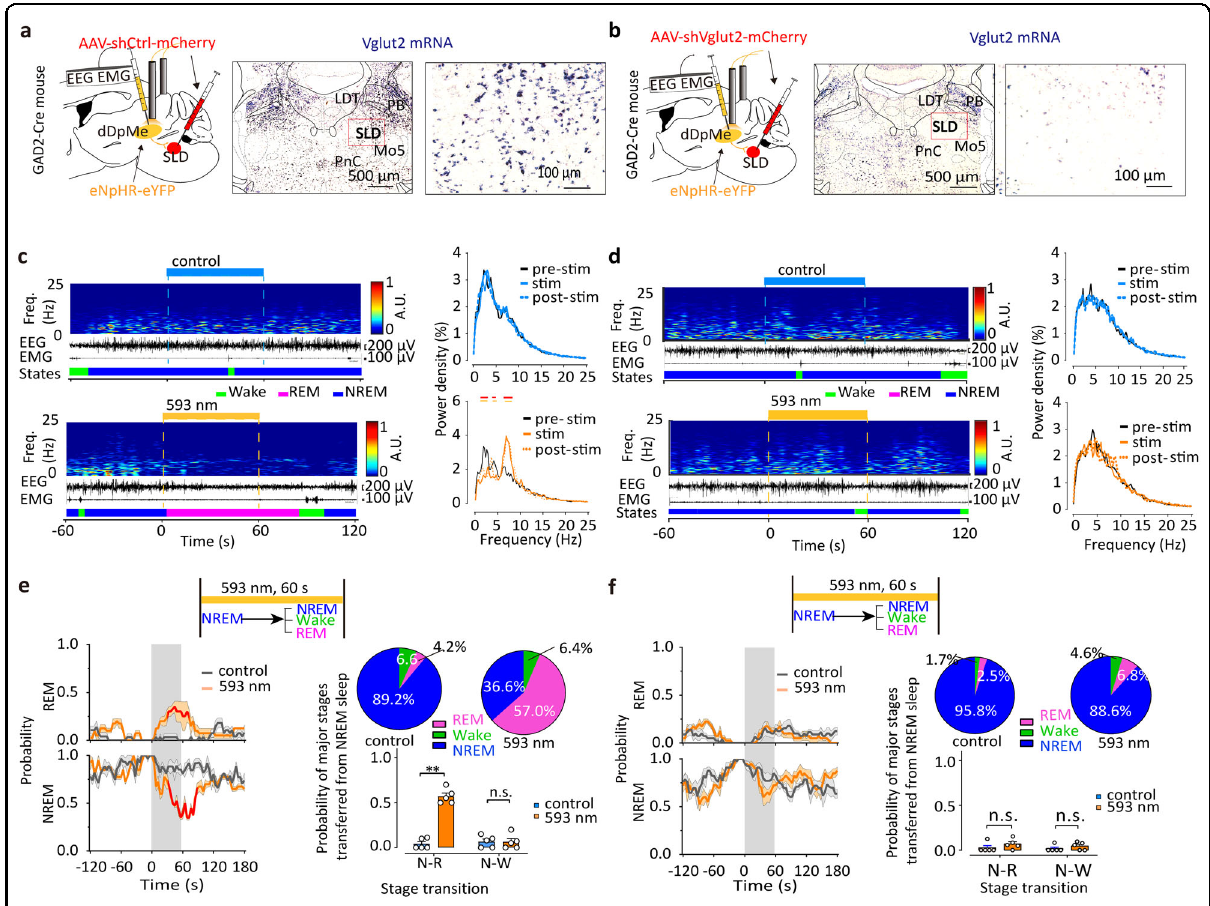
Fig. 4 dDpMe GABA → SLD Glu neural pathway is necessary for REM sleep termination and REM-to-NREM transitions. a , b Sagittal diagram for optical inhibition of the dDpMe by eNpHR after shRNA interference by shCtrl or shVglut2. shRNA interference of Vglut2 in the SLD was identi fi ed by in situ hybridization labelling Vglut2 -mRNA. c, d Typical examples of EEG power spectrograms, EEG/EMG traces, and the mean percentage of power densities from GAD2-Cre mice with bilateral 593-nm laser delivery (bottom) or 470-nm laser delivery (top) to dDpMe eNpHR-expressing neurons. The horizontal bars indicate a signi fi cant difference ( P < 0.01, two-way ANOVA with post-hoc Sidak ’ s multiple-comparison tests compared to 60-s pre- stimulation conditions; the red bars indicate pre-stimulation vs stimulation, and the orange bars represent pre-stimulation vs post-stimulation). Time courses of REM sleep (top) or NREM sleep (bottom) in GAD2-Cre mice with control or SLD Glu interference after 593-nm or 470-nm laser stimulation of dDpMe eNpHR-eYFP-expressing neurons initiated from NREM sleep. The red lines indicate a signi fi cant difference ( P < 0.05, two-way ANOVA with posthoc Sidak ’ s multiple comparison tests: shCtrl, F (1,608)(REM) = 128.1, P < 0.001, F (1,608)(NREM) = 232.5, P < 0.001; shVglut2, F (1,608)(REM) = 0.56, P = 0.46, F (1,608)(NREM) = 0.02, P = 0.89). e , f P ie chart and histograms showing major brain states during laser stimulation initiated from NREM sleep in the shCtrl group ( e ) or shVglut2 group ( f ), as assessed by two-way ANOVA with post-hoc Sidak ’ s multiple comparison tests: SLD-shCtrl group, F (1,16) = 64.74, P (NREM → REM) = 8.45 × 10 -9 ; SLD-shVglut2 group, F (1,16) = 2.71, P (NREM → REM) = 0.33. shVglut2 group , n = 5; shCtrl group, n = 5. Data represent means ± SEM. * P < 0.05, ** P < 0.01. PnC caudal part of pontine reticular